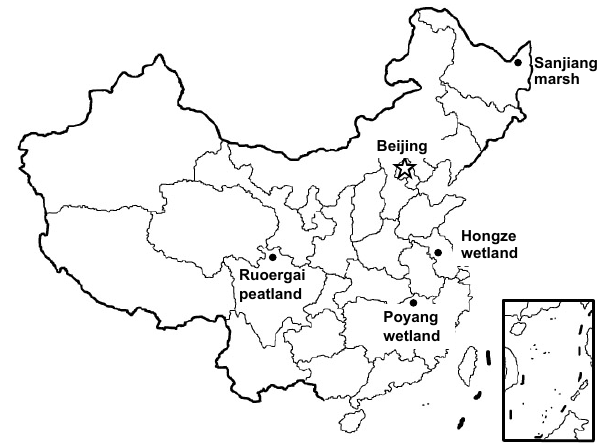
Fig. 1. Location of studied natural wetlands in